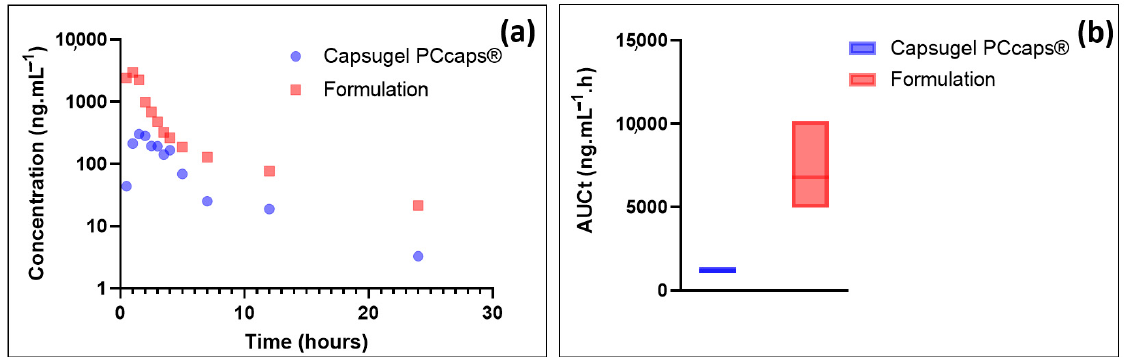
Figure 7. ( a ) Plasmatic concentrations of EGCG as a function of time; ( b ) box plots of the total area under curve.